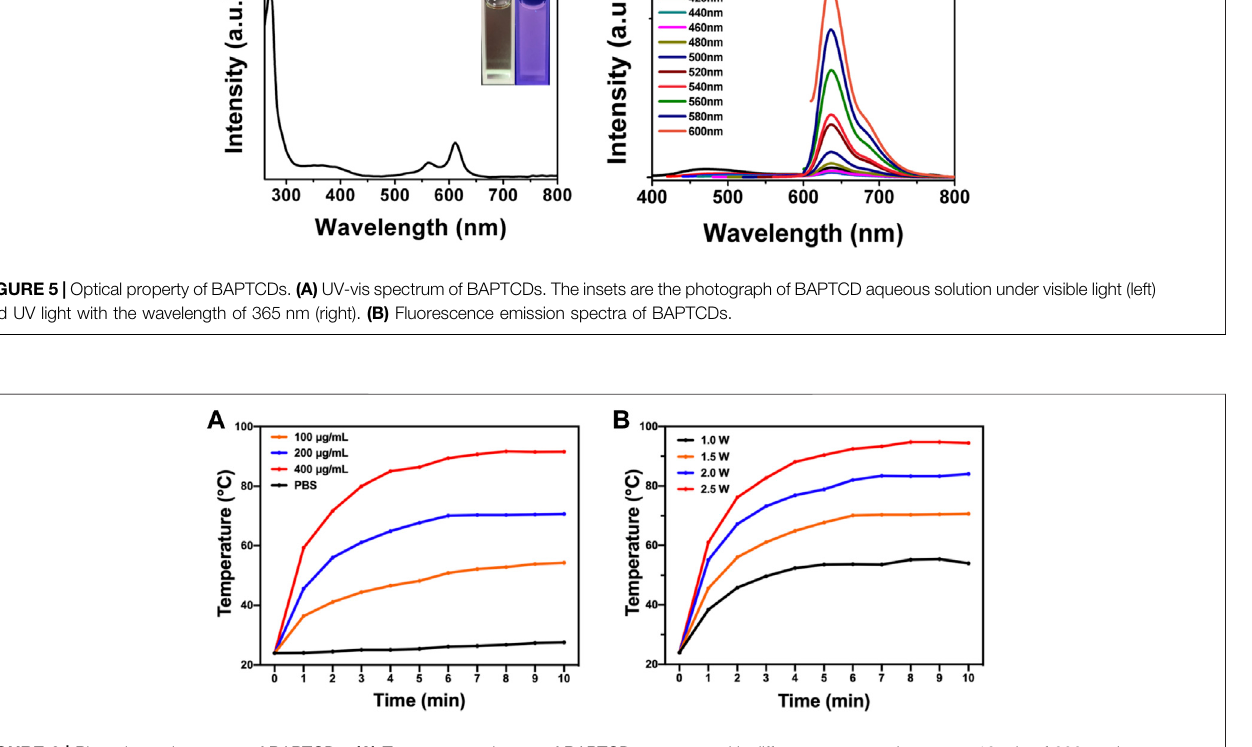
Frontiers in Bioengineering and Biotechnology |